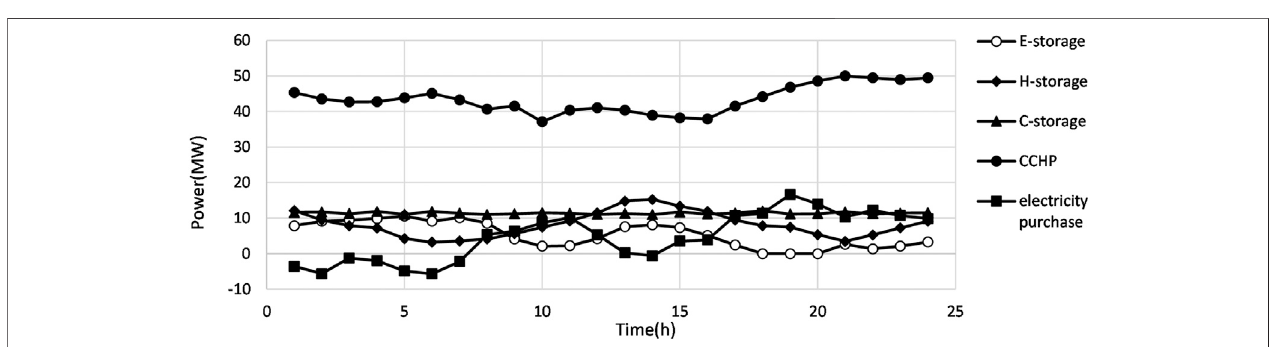
FIGURE 7 | Day-ahead optimization dispatch plan of a typical day in